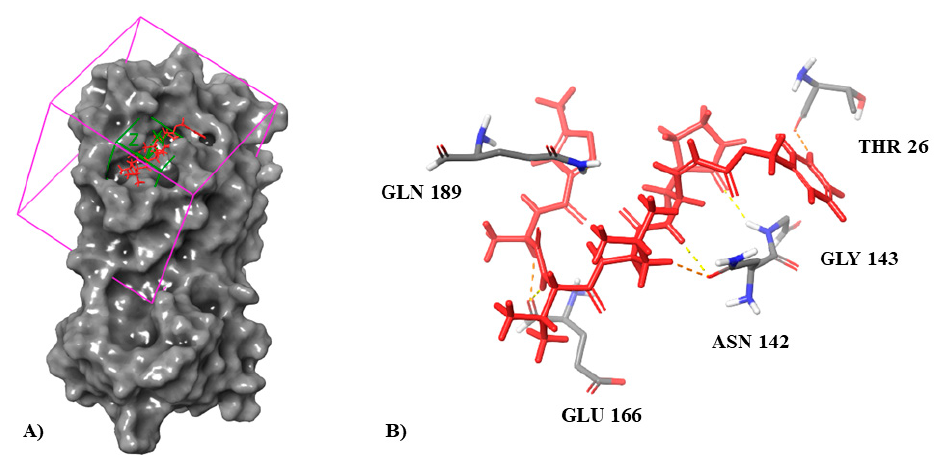
Figure 2. ( A ) Binding pocket for Mpro crystallized protein (PDB:6LU7) docking studio. ( B ) Interaction of Mpro co-crystallized ligand (inhibitor N3) with key catalytic residues.